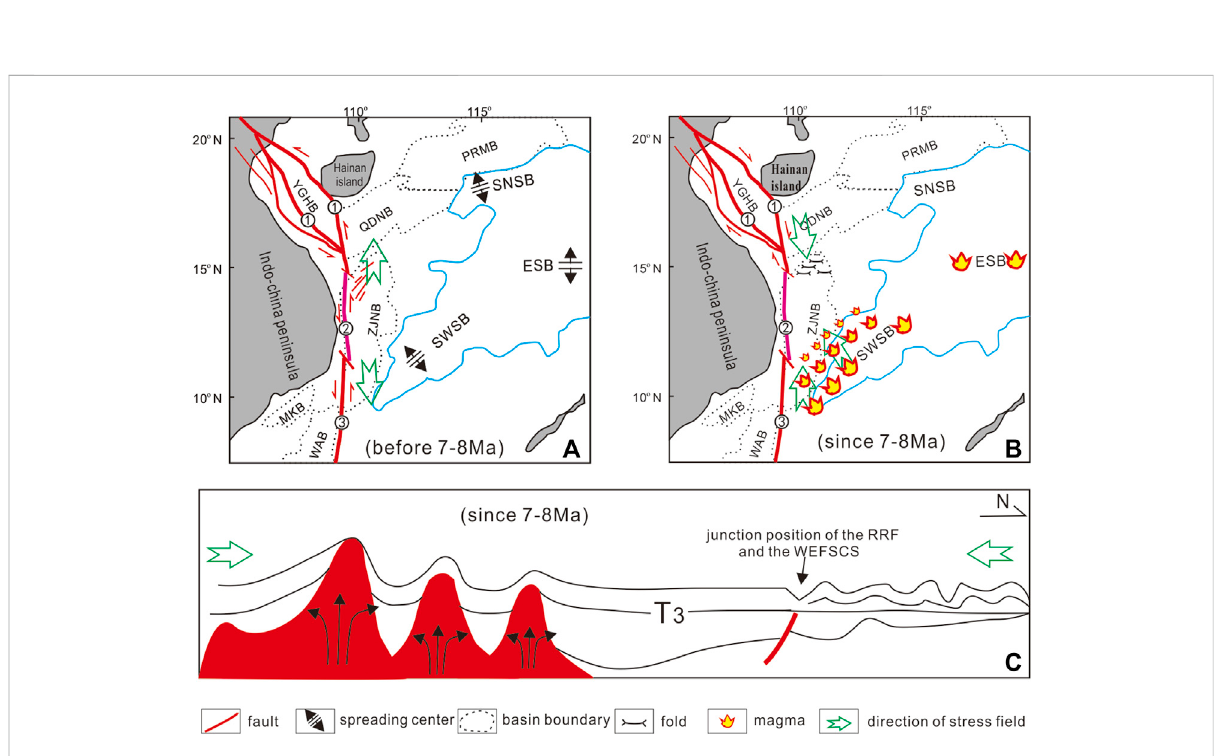
FIGURE 8 TectonicdynamicsmodeloftheZhongjiannanBasinbeforeandafterthelateMiocene.YGHB-YinggehaiBasin,PRMB-PearlRiverMouthBasin, QDNB- Qiongdongnan Basin, ZJNB- Zhongjiannan Basin, WAB- Wan ‘ an Basin, NWSB- northwest subbasin, SWSB- southwest subbasin, ① -RRF, ② -WEFSCS, ③ -Wan (cid:1) anFault. (A) Tectonicsettingandstress fi eldorientationofZhongjiannanBasinbeforethelateMiocene. (B) Tectonicsettingand stress fi eldorientationofZhongjiannanBasinafterthelateMiocene. (C) Structural modeloftheS-Npro fi leinthewesternSouthChinaSeaafter the late